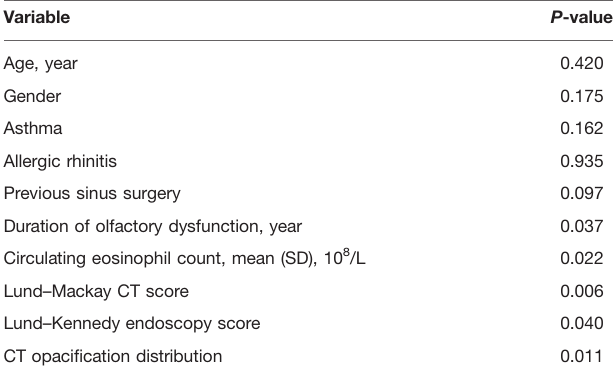
TABLE 2 | Univariate screening for predictive variables on postoperative olfactory improvement.